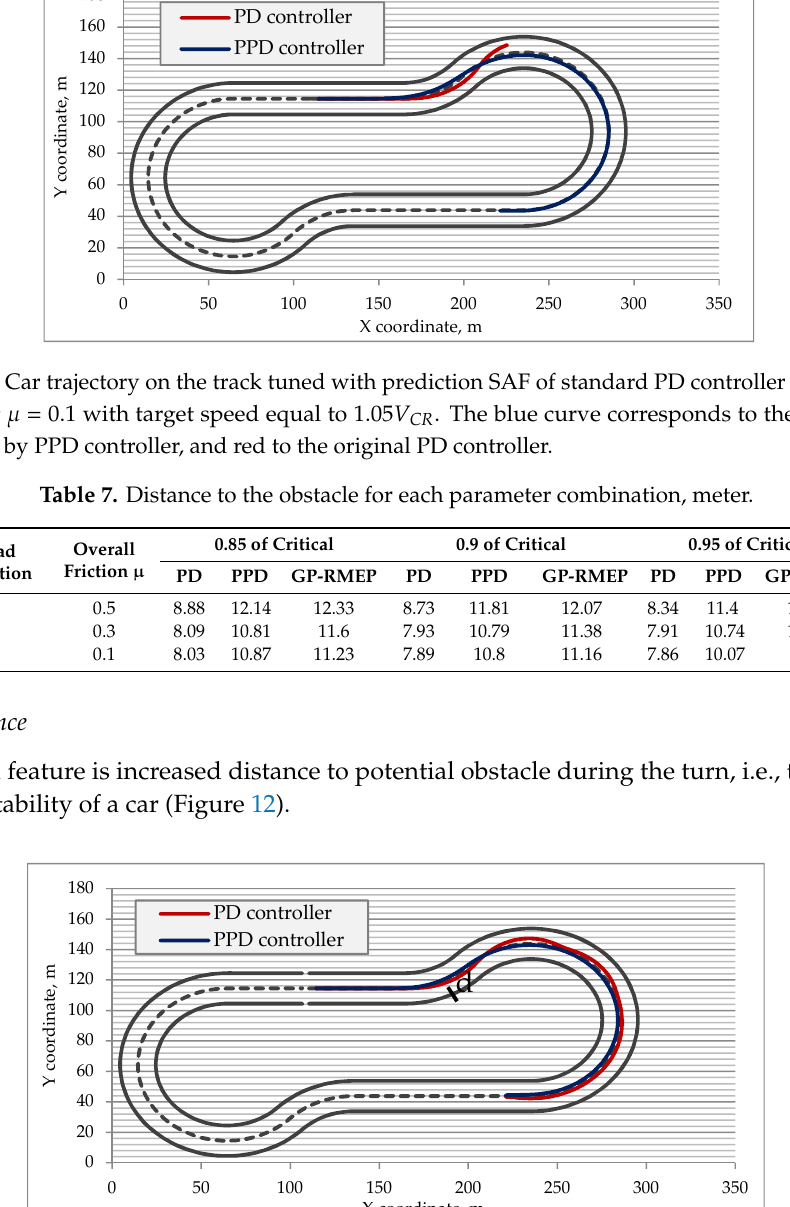
Figure 12. Distance between the car and obstacle (road turn) that caused the turn friction coefficient µ = 0.3 with target speed equal to 0.95(cid:1848) (cid:3004)(cid:3019) .